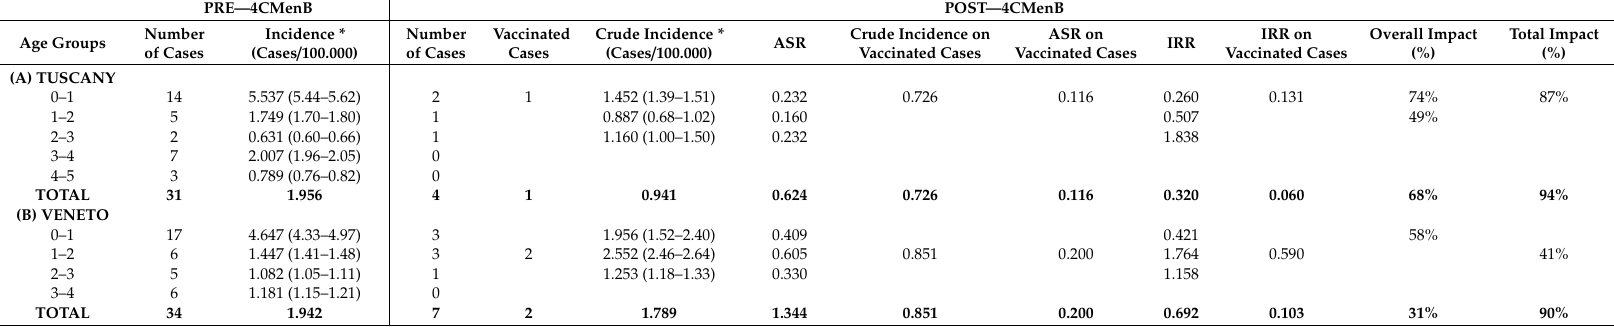
Table 3. Neisseria meningitidis B cases, incidences and impact for age groups, vaccinated or not, in Tuscany and Veneto during pre and post-vaccination eras.